Question: Give a one-sentence summary of this figure.
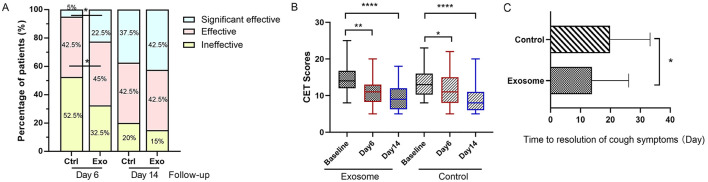
Answer: Clinical efficacy of nebulized 3D-EVs for post-COVID-19 chronic cough. (A) Efficacy categorization by Cough Evaluation Test (CET) score improvement at Day 6 and Day 14. (B) Median CET score changes from baseline to Day 6 and Day 14. (C) Time to cough symptom resolution. Statistical analyses: chi-square test for (A) , Wilcoxon signed-rank test for (B) , unpaired t -test for (C) . * P < 0.05, ** P < 0.01, **** P < 0.0001.